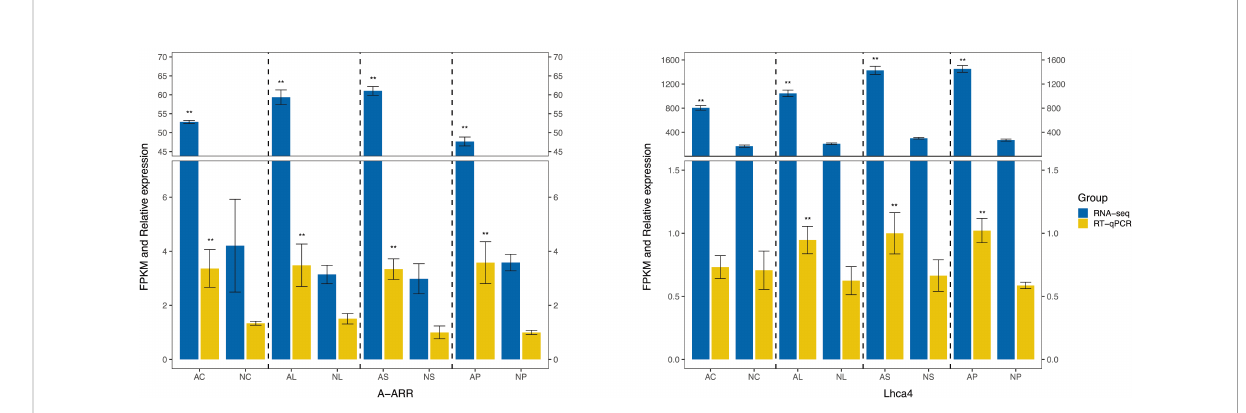
FIGURE 9 RT-qPCR-based veri fi cation of the RNA-seq analysis results. Asterisk represents statistical signi fi